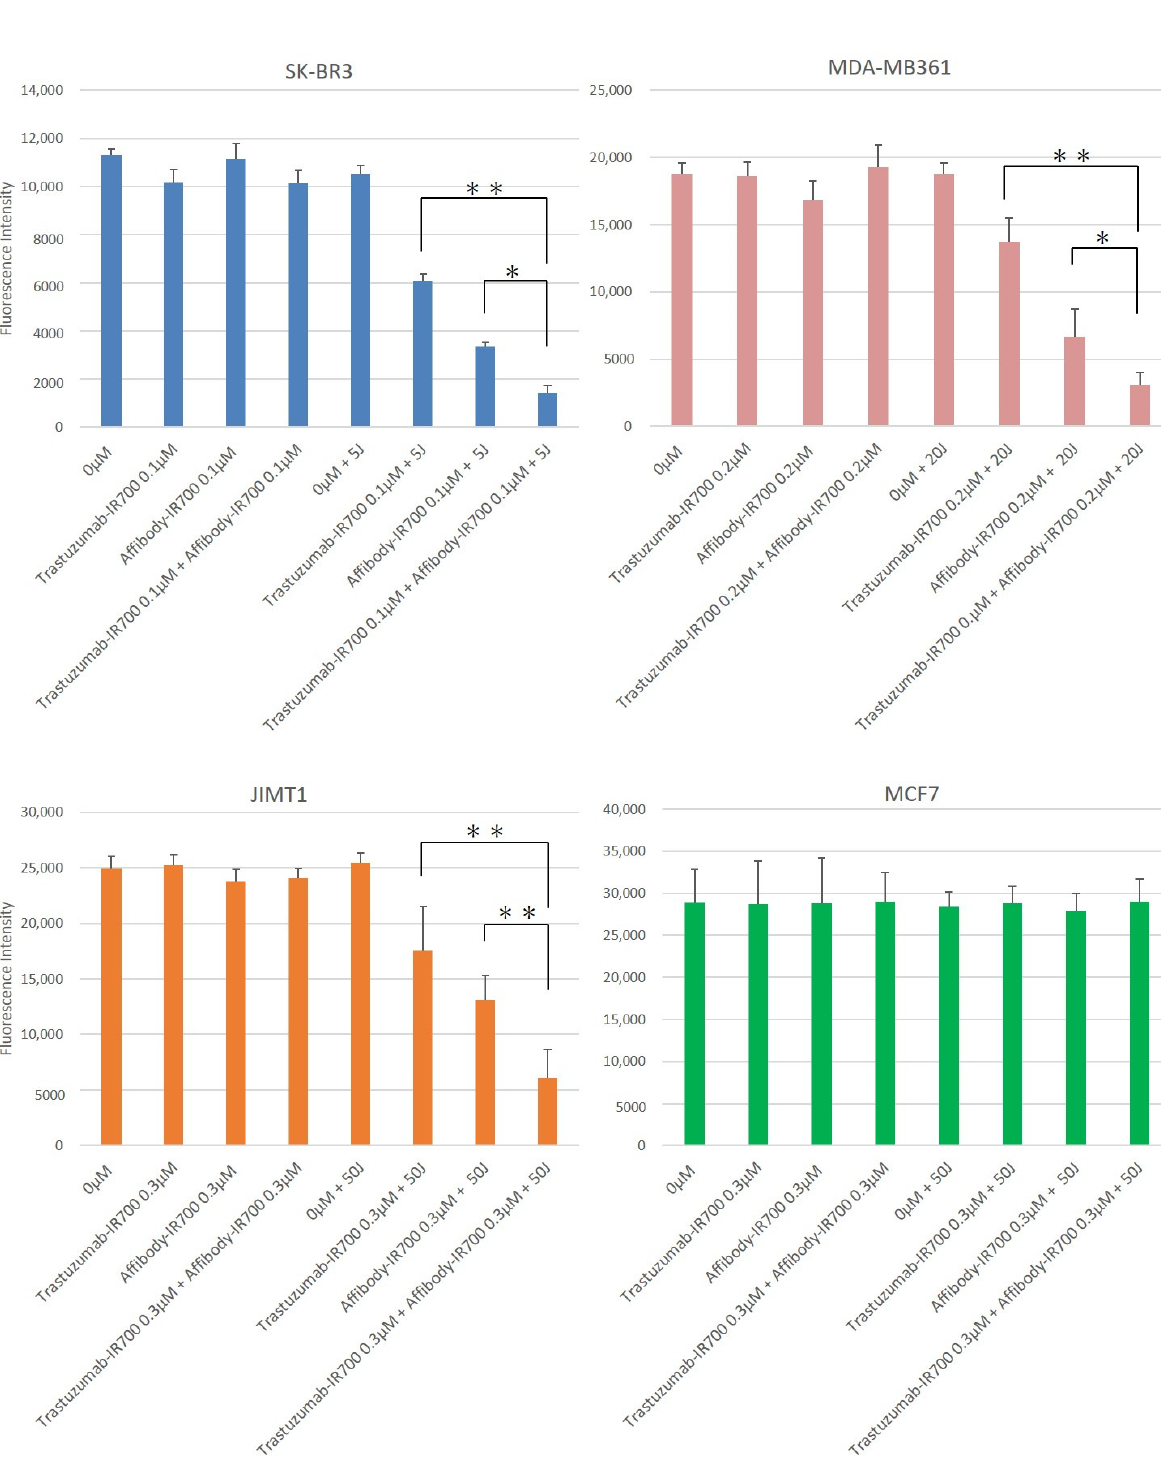
Figure 6. Fluorescence intensity indicating the cell viability 24 h after NIR-PIT. HER2-positive cells (SK-BR3, MDA-MB361, and JIMT1) treated with the combination of NIR-PIT showed lower cell viability than the cells treated with NIR-PIT using either HER2 Affibody-IR700Dye conjugate or trastuzumab-IR700Dye conjugate, with no effect of NIR-PIT on MCF7 cells. When SK-BR3 cells were exposed to 0.1 µM of the conjugates and 5 J/cm 2 irradiation, MDA-MB361 cells were exposed to 0.2 µM of the conjugates and 20 J/cm 2 irradiation, and JIMT1 cells were exposed to 0.3 µM of the conjugates and 50 J/cm 2 irradiation, they showed the most significant difference between NIR-PIT using either HER2 Affibody-IR700Dye conjugate or trastuzumab-IR700Dye conjugate and the combination of both with NIR-PIT ( n ≥ 6; * p < 0.05; ** p < 0.01, one-way ANOVA with Tukey–Kramer post hoc tests). Data are presented as means ± SD.